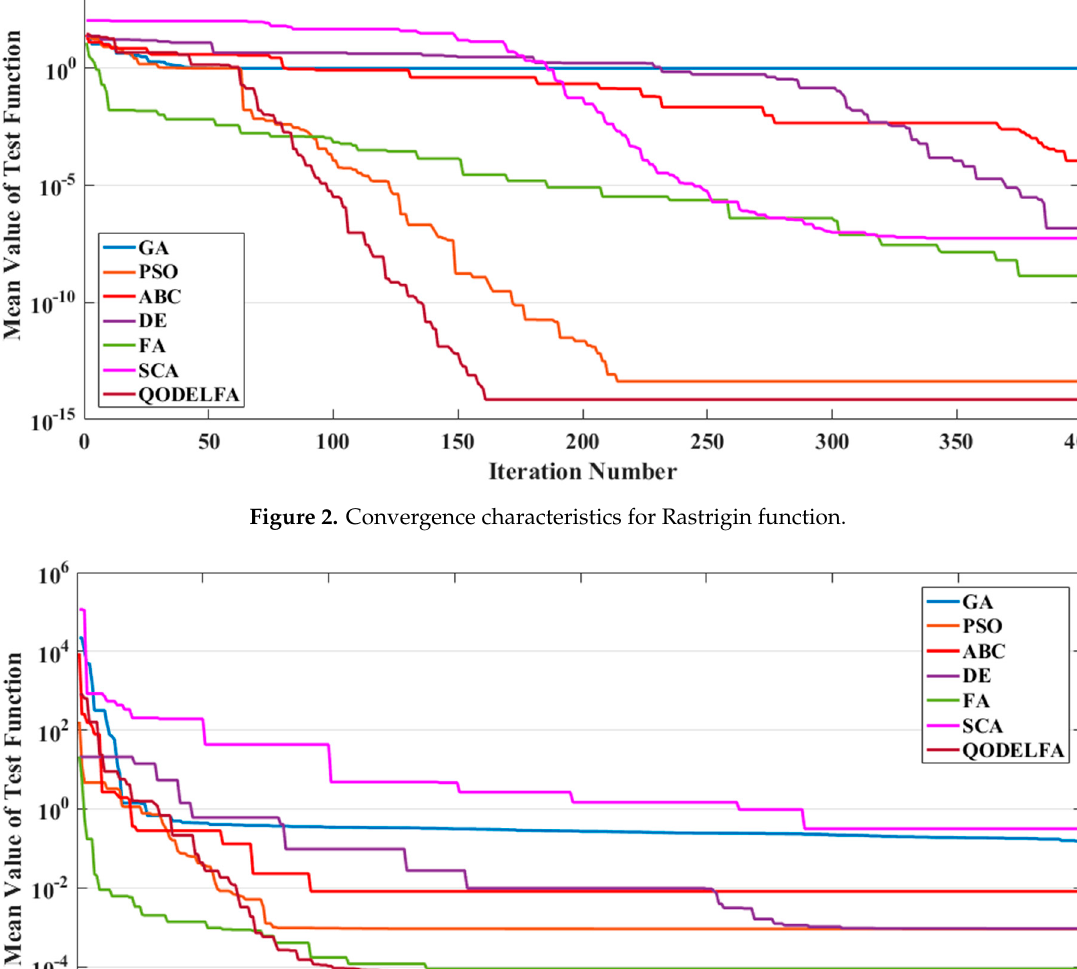
Figure 3. Convergence characteristics for Perm function 0, d , β .